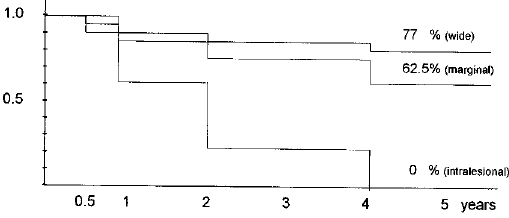
Fig. 5. Kaplan± Meier survival analysis in relation to surgical margin (stage III tumors were